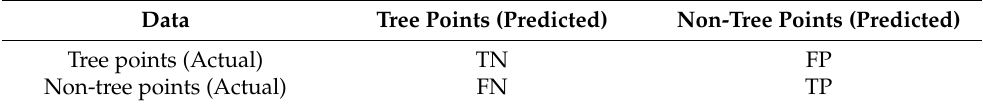
Table 1. Error matrix for binary classification. Data Tree Points (Predicted) Non-Tree Points (Predicted) Tree points (Actual) TN FP Non-tree points (Actual) FN